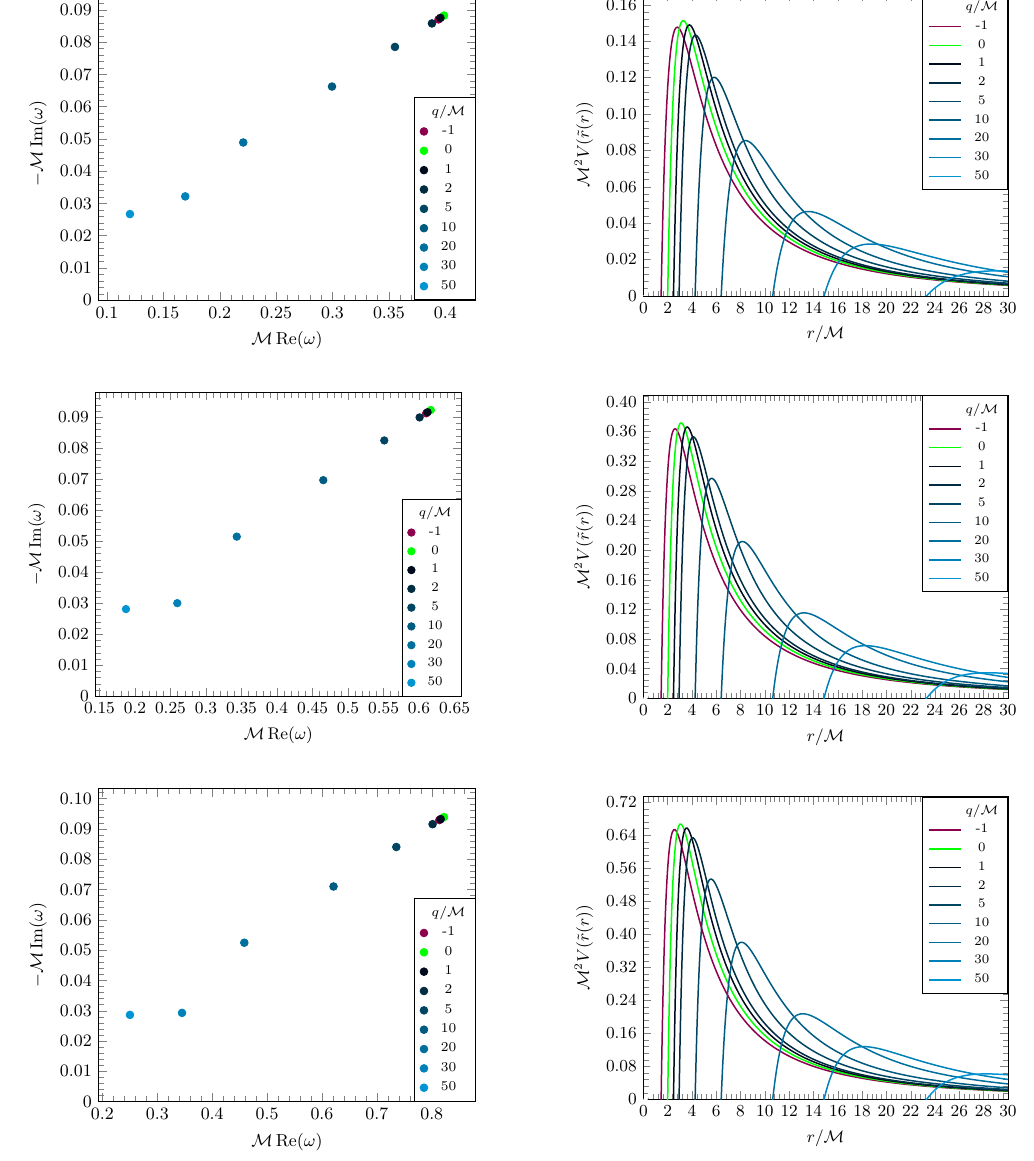
Figure 2 . Left panel: odd spectrum of QNM for n = 0 and some representative values of q . Right panel: the plot of the corresponding potential V (~ r ( r )) . From top to bottom: ‘ = 2, ‘ = 3, ‘ = 4.